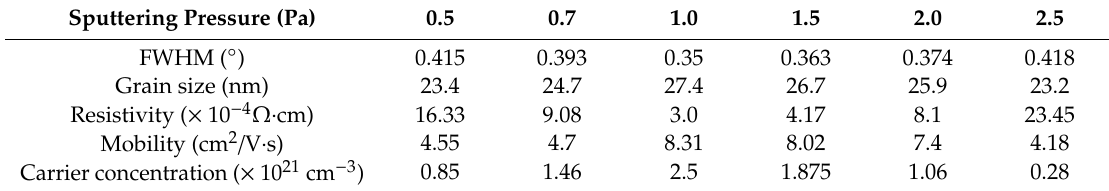
Carrier concentration ( × 10 21 cm − 3 )